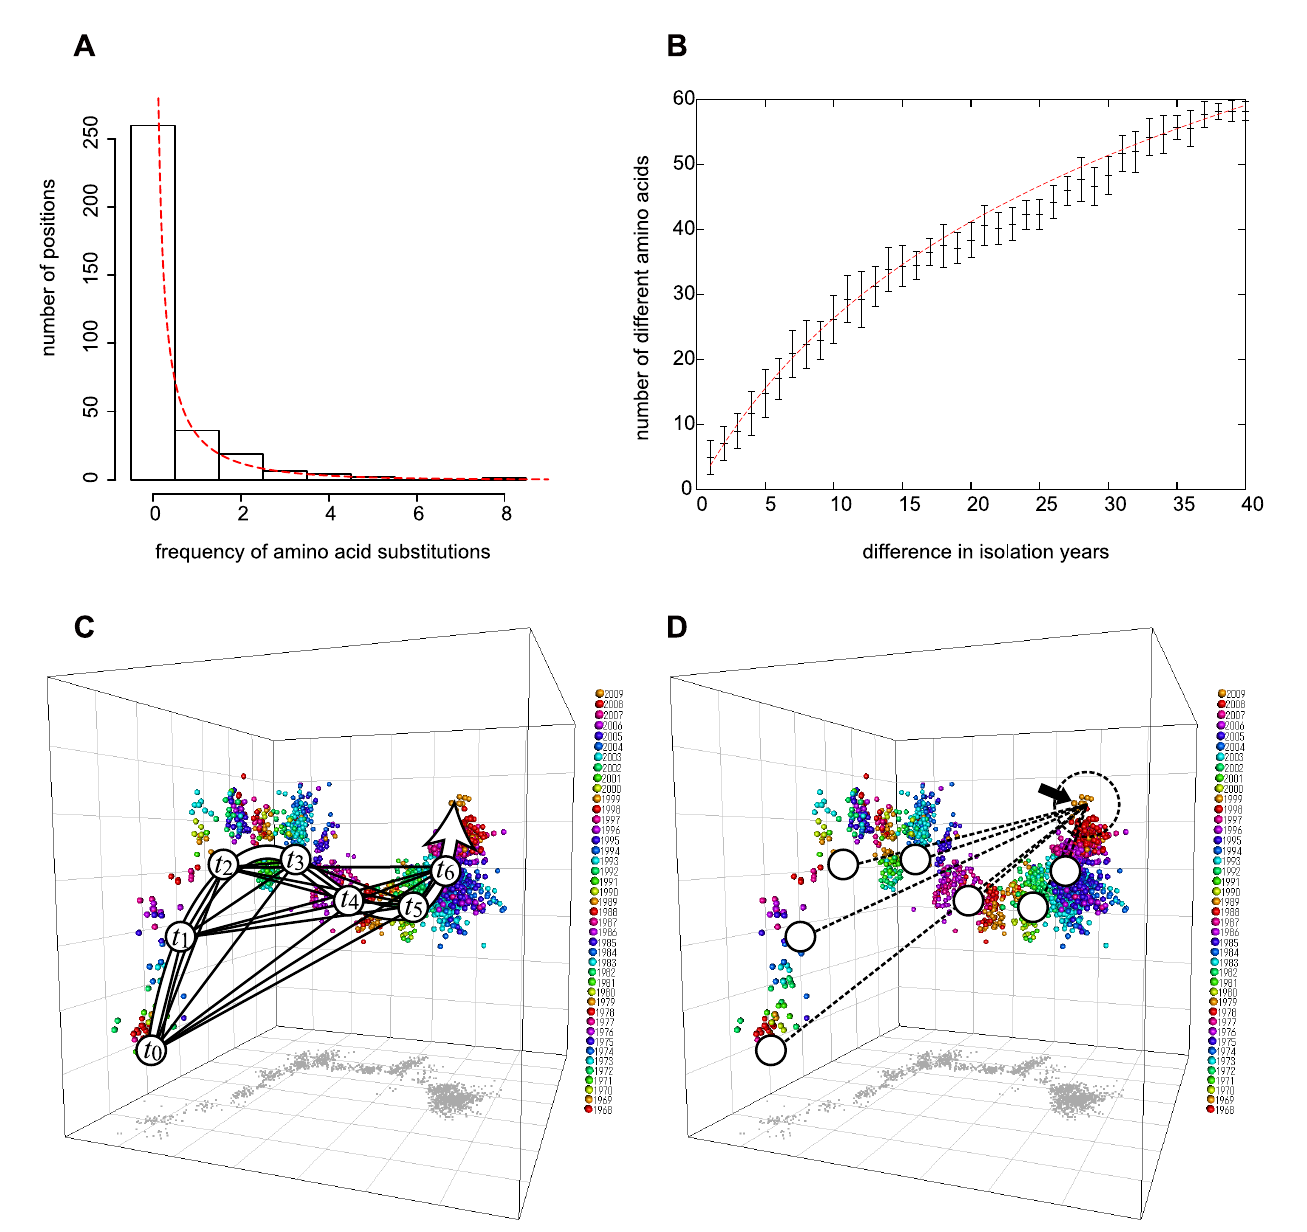
Figure 3. The amino acid substitutions on the gnarled trunk. (A) the distribution of the number of positions that were substituted on the trunk from 1968 to 2009. The gamma distribution that has a mean substitution frequency of 0.418 and a variance of 1.155 is superimposed. (B) The number of different amino acids between the trunk sequences plotted against the difference in their isolation years. The horizontal bars indicate mean values, and vertical lines indicate 6 1 standard deviation of the number of different amino acids. A non-linear regression curve using the formula d ~ 328 | (1 { ( a = ( a z (cid:2) rrt )) a ) is superimposed ( a =0.129, (cid:2) rr =0.0118), showing good fit to the actual data (P , 0.001). (C) A schematic illustration of trunk viruses and the sequence dissimilarities among them. A trunk virus is a virus located near the main trunk. Circles labelled with t 0 , ... , t 6 are examples of trunk viruses. The sequence dissimilarities among trunk sequences are shown by solid lines. (D) The selection of a Leading Bud. Using the formula of d ~ 328 | (1 { ( a = ( a z (cid:2) rrt )) a ) , one may calculate the expected sequence dissimilarities between a future trunk virus and past trunk viruses (dotted lines). The bold arrow indicates a candidate for Leading Buds. For the coming influenza season in 2010, A/Thailand/CU-B110/2009(H3N2) was predicted to be the most likely candidate virus (Table S2). was constantly curved in the MDS-constructed 3D space. This position to another according to a gamma distribution. The estimated parameters of the gamma distribution allowed us to unique property of the sequence evolution indicated that the evolution on the trunk favoured multiple substitutions at the same predict the amino acid substitutions on HA in subsequent years positions on HA molecules. Our study found that the curvature with reasonable accuracy. was relatively constant and reasonably explained by assuming that The small value of its gamma parameter estimated in this study the rate of amino acid substitutions on HA varied from one suggested that most of amino acids on HA remained unchanged,